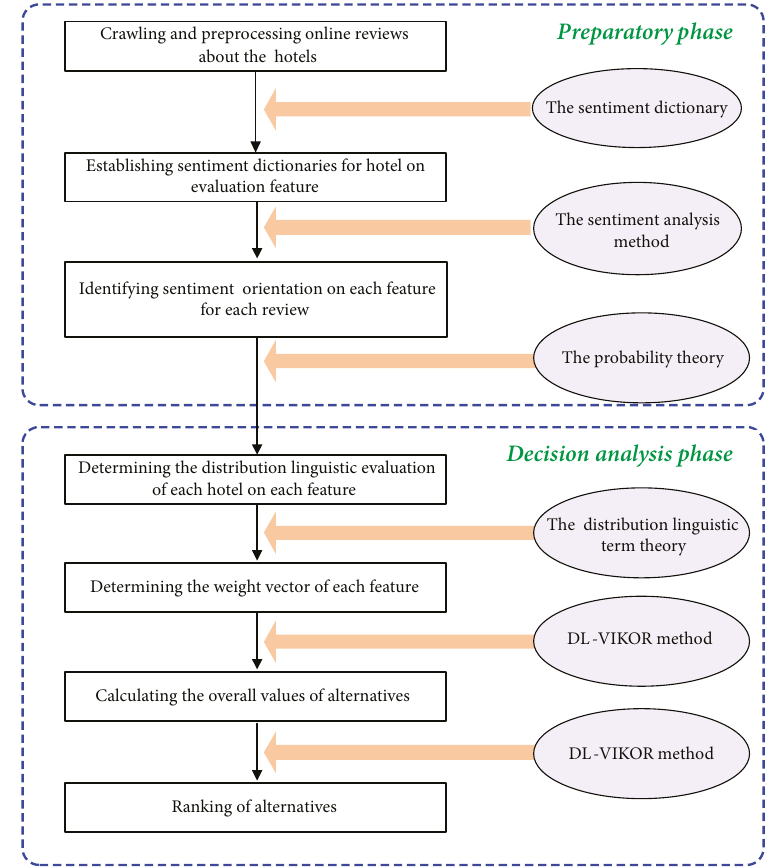
Figure 3. The resolution procedure for the problem of sorting hotels with online